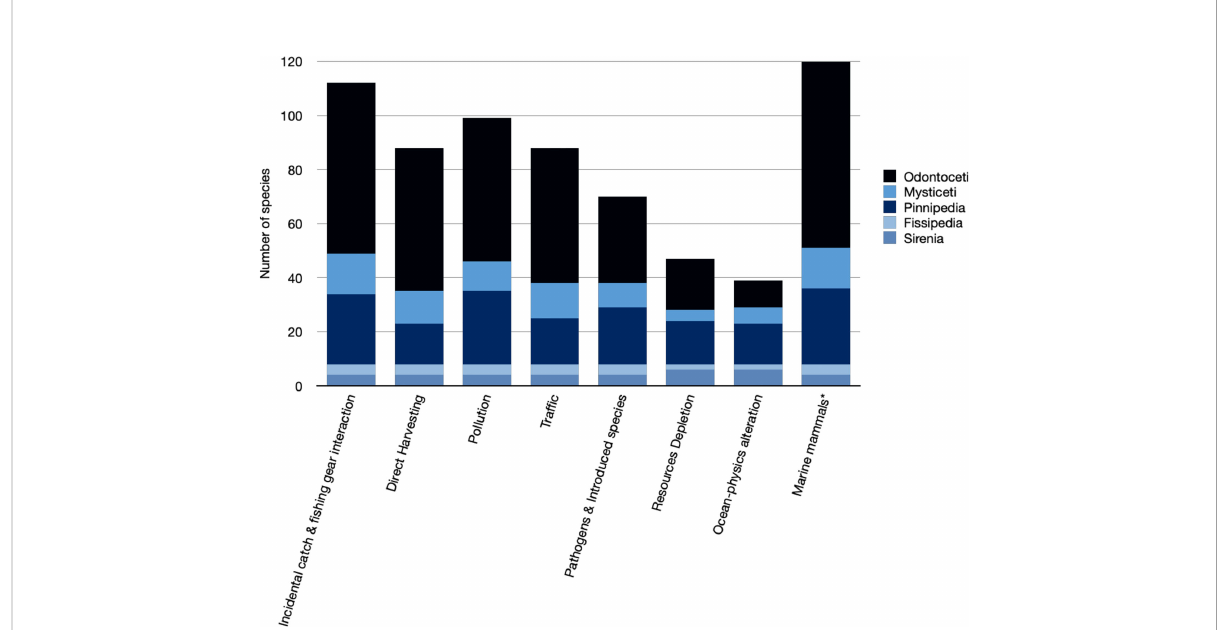
FIGURE 1 Number of species of each taxon documented to be affected (between 1991 and 2016) by different threat categories. Source: Adapted from Avila et al,